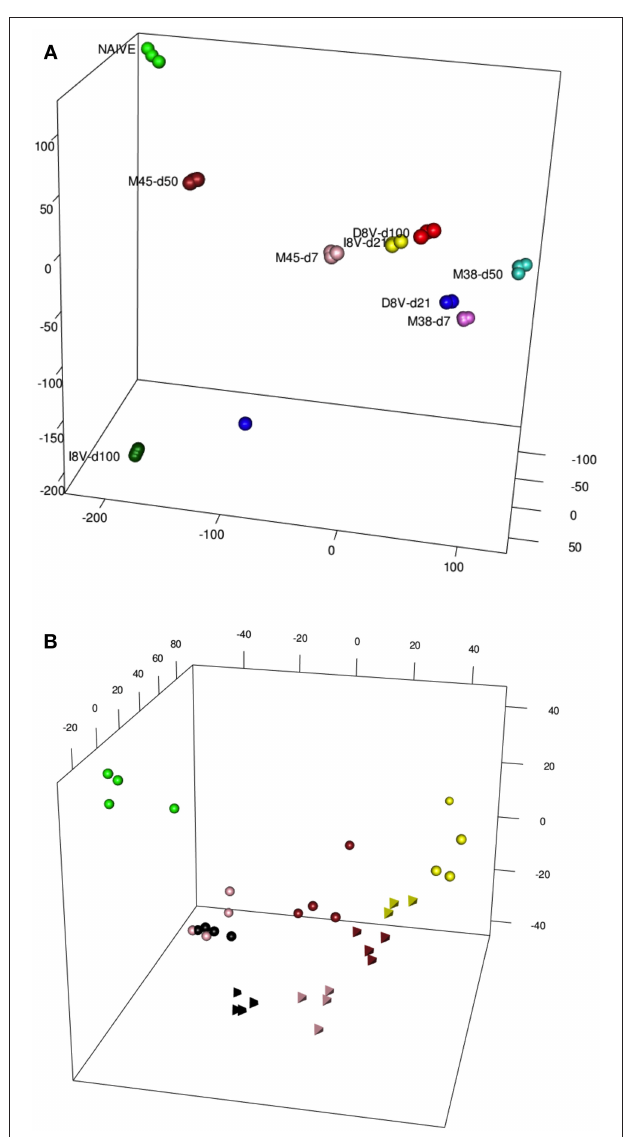
FIGURE 2 | (A) A PCA of Inflating/non-Inflating CD8T cells. 3D PCA showing distribution of transcription profiles of two independent models of Inflating samples (M38, D8V) and non-Inflating Samples (M45,I8V), at acute stages (days 7 or 21) and later stages (days 50 or 100), and naive samples. (B) PCA of Exhausted/non-Exhausted CD8T cells. 3D PCA showing distribution of transcription profiles of a model of Exhaustion (Cl13,Tetrahedrons), with non-Exhaustive samples (Arm, spheres) at different stages, and naive samples. Stages: 6 days (yellow), 8 days (brown), 15 days (pink), 30 days (black), naive